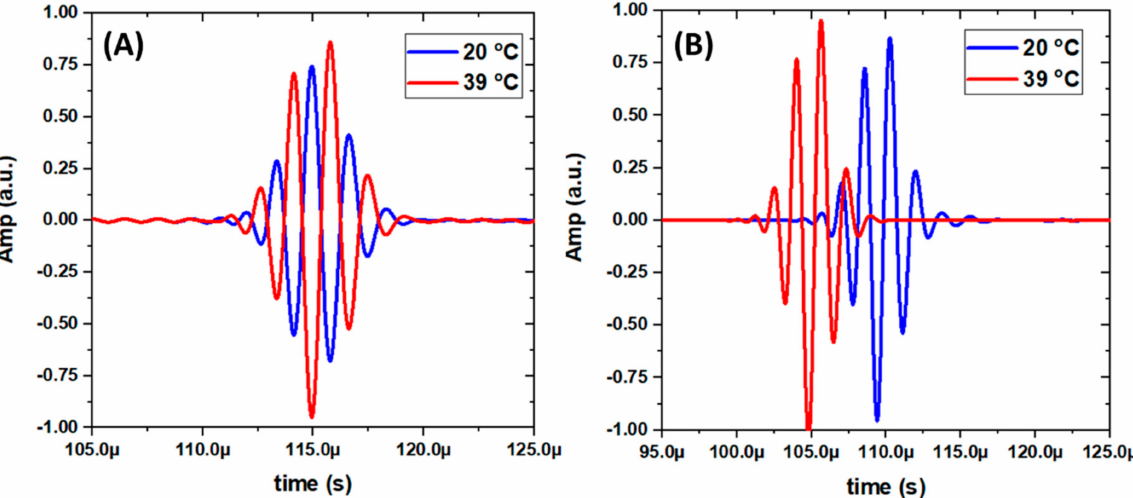
Figure 4. Measured acoustic reflection signals obtained from the setup shown in Figure 3. ( A ) Reflections. ( B ) Transmissions. Measured acoustic transmission signals obtained from the setup shown in Figure 3.